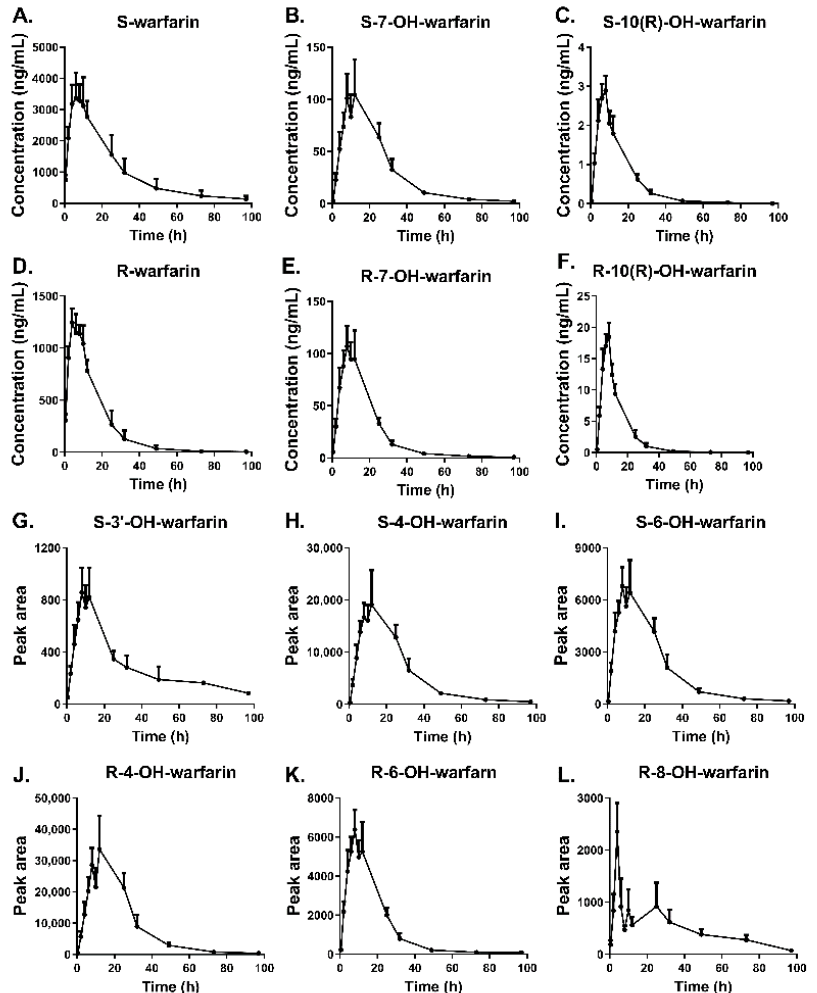
Figure 5. Mean plasma concentration/peak area–time curves of warfarin and its hydroxylation metabolites in SD rats after oral administration of warfarin 2 mg/kg ( n = 8). Quantification of S/R-warfarin ( A , D ), S/R-7-OH-warfarin ( B , E ) and S/R-10(R)-OH-warfarin ( C , F ); and relative quantification of S-3 (cid:48) -OH-warfarin ( G ), S/R-4 (cid:48) -OH-warfarin ( H , J ), S/R-6-OH-warfarin ( I , K ), and R-8-OH- warfarin ( L ). Table 5. Pharmacokinetic parameters of warfarin and its main hydroxylation metabolites after oral administration of warfarin (2 mg/kg) to SD rats ( n = 8, Mean ± SD).